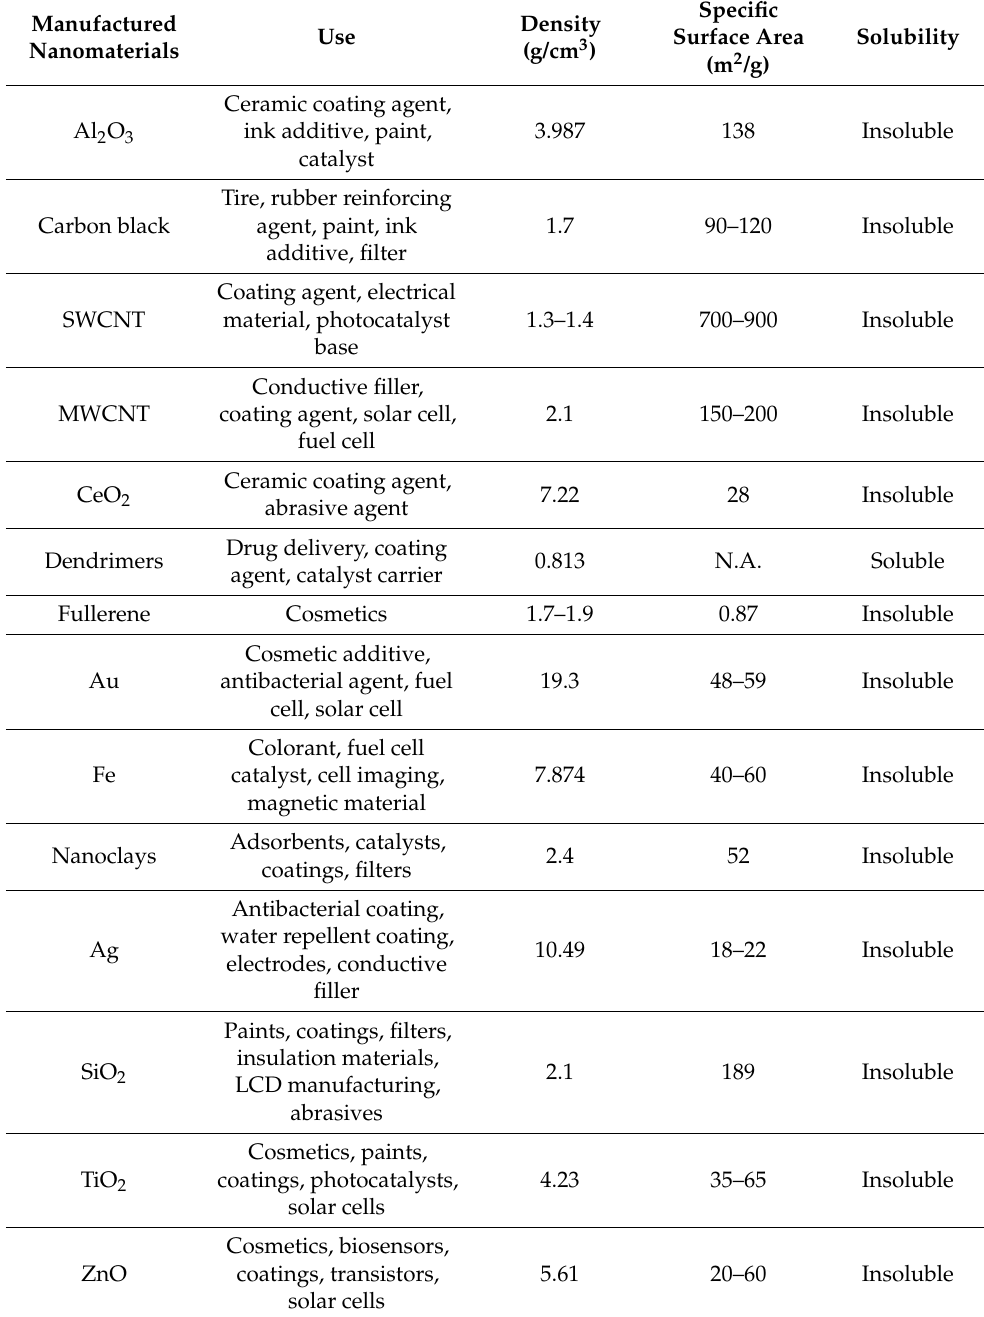
Table 1. Consumer uses and physical and chemical characteristics of manufactured nanomaterials